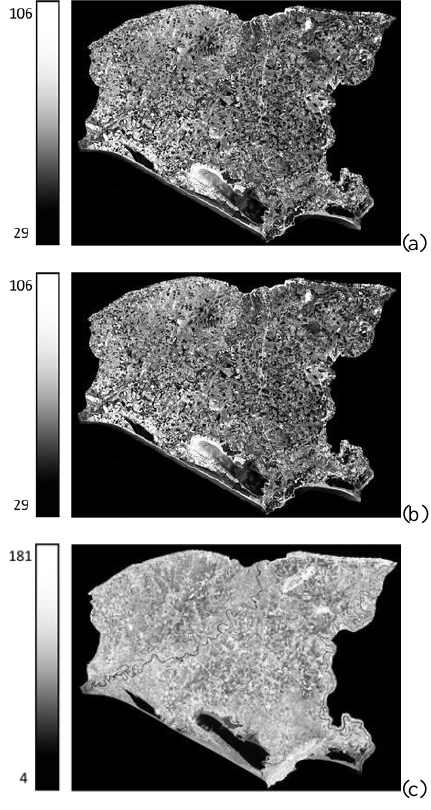
Figure 2. Salinity indices images of Seyhan plate on 21st March, 2010. (a) SI 1 (b) SI 9 (c) SI